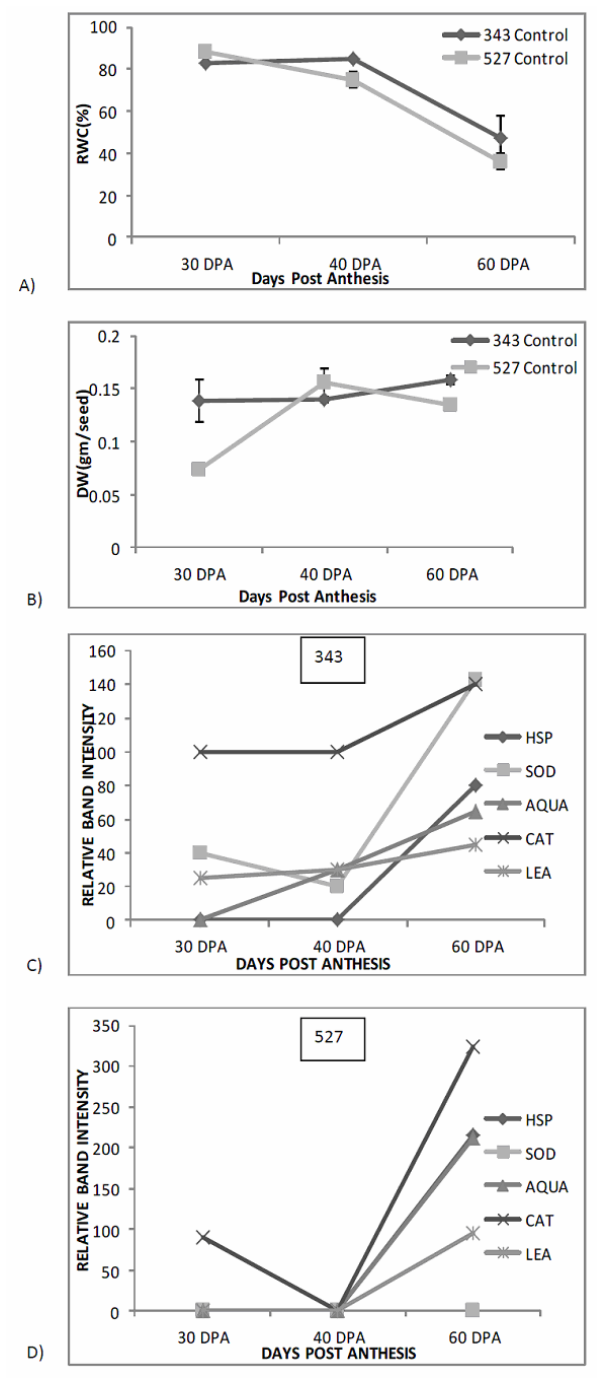
Fig. 7: Developmental regulation of RWC (A), DW (B) and Quantitative analysis of developmentally regulated immune- reactive boiling soluble proteins in seeds of drought sensitive cv. ‘PBW 343 ’ (D) and drought tolerant cv. ‘PBW 527 ’ (E) cultivars of T. aestivum harvested at three different stages: 30 DPA, 40 DPA, 60 DPA under control and drought conditions. Quantitative analysis was carried by measuring the relative band intensities of respective immune-reactive BSPs using Gel visualisation, Documentation and Analysis system (Bio-Rad, USA). DPA: Days Post